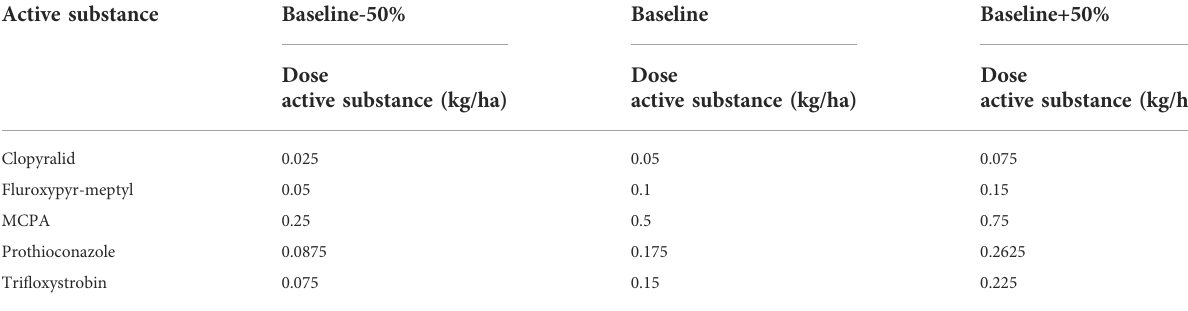
TABLE 2 Description of application scenarios used in this case study for the fi ve selected